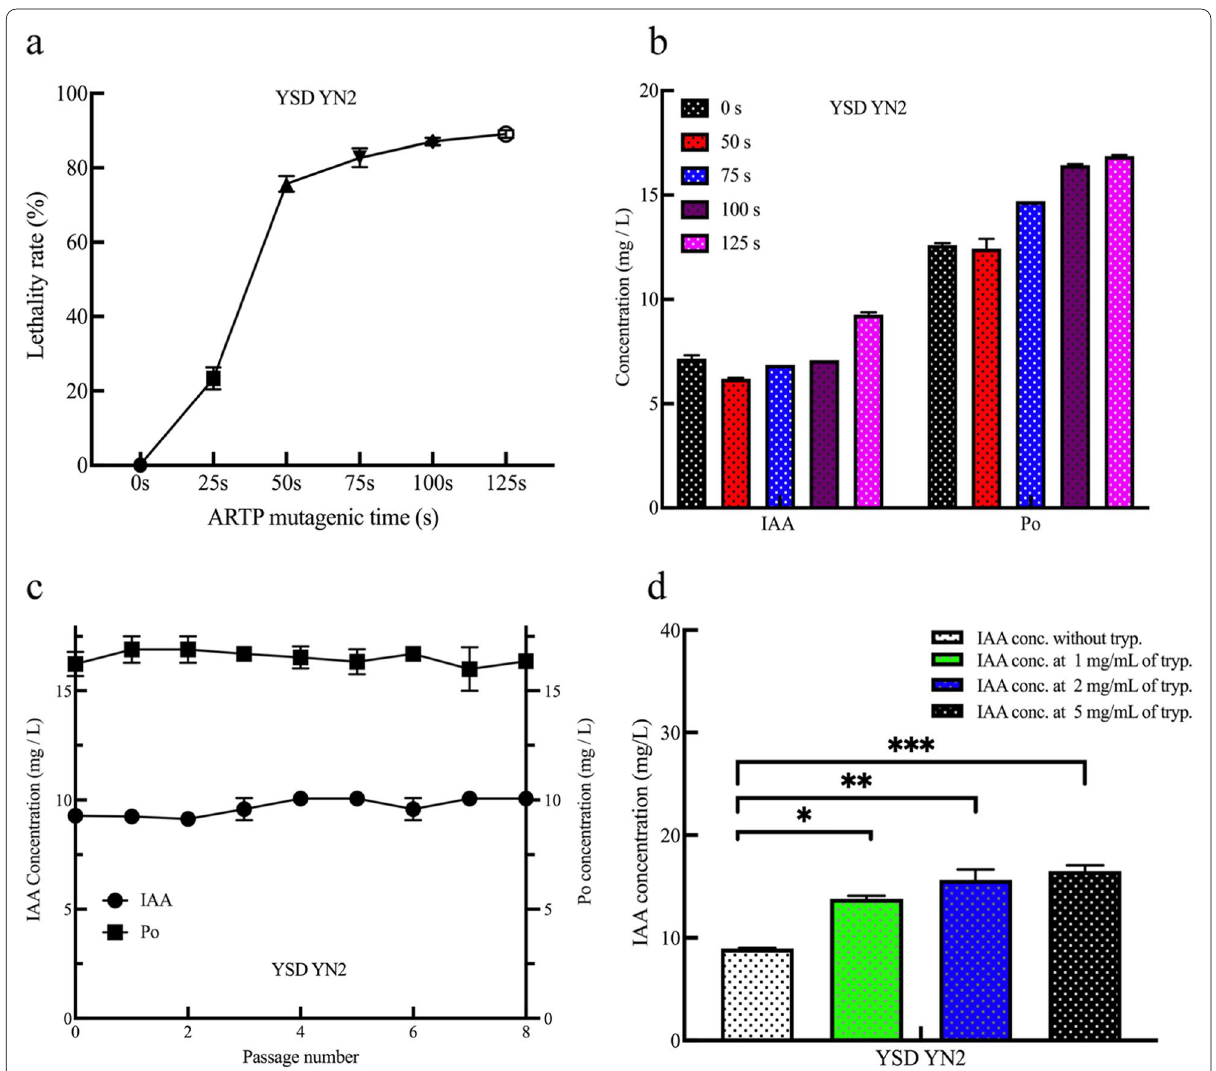
Fig. 3 Strain improvement and screening by ARTP. a Lethality rate of YSD YN2 under different mutagenic time. b The IAA concentration and organic phosphate concentration (Po) under different mutagenic time. c Hereditary stability of mutant strain. d Quantitative production of IAA by endophytic bacterial isolates; with and without tryptophan. Experiments were performed in triplicate, and the values are represented as mean standard deviation. Data are presented as the mean of 3 replicates. Lowercase for different IAA concentrations at the same strains ( P multiple-comparison